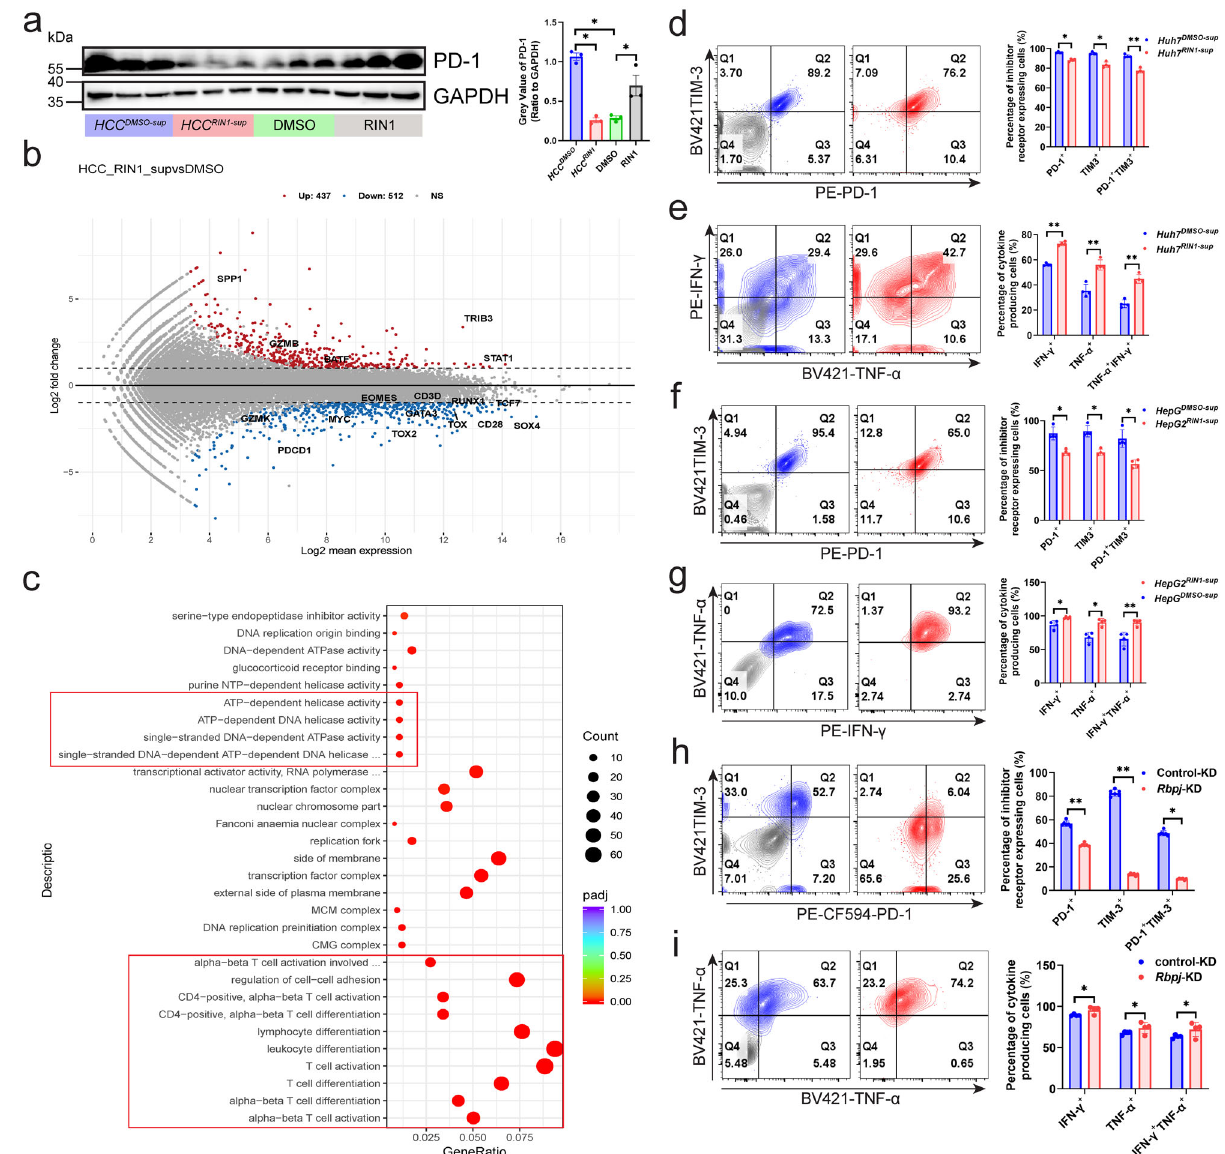
Fig. 4 Regulatory effect of HCC RIN1-sup on the transcriptional pro fi le of CD8 + T cells. a Western blot showing PD-1 expression in mouse HCC in fi ltrating CD8 + T cells ( n = 3). b MA plot of RNA-seq data from Huh7 DMSO-sup versus Huh7 RIN1-sup -treated patient HCC in fi ltrating CD8 + T cells ( n = 3). Genes with elevated expression in the Huh7 RIN1-sup -treated CD8 + T cells ( P adj < 0.05 and log2(fold change) > 1) were marked in red, genes with reduced expression ( P adj < 0.05 and log2(fold change) < − 1) were highlighted in blue. Selected genes were labeled. c GO enrichment analysis of RNA-seq data from Huh7 DMSO-sup versus Huh7 RIN1-sup -treated CD8 + T cells ( n = 3). d – g Expression of inhibitory receptors ( d , f ) and cytokines ( e , g ) on CD8 + T cells from Huh7 RIN1-sup ( d , e ) and HepG2 RIN1-sup ( f , g ) ( n = 4). Gray indicated isotype control. h , i Expression of inhibitory receptors ( h ) and cytokines ( i ) on CD8 + T cells from the tumors of control-KD and Rbpj -KD ( n = 7). Gray indicated isotype control. Mea n ± SD. Statistical signi fi cance determined by paired two- tailed t -test ( a , b , d – i ). * P < 0.05; ** P < and increases hepatic lipid content 17 . To investigate how L-kynurenine by RBPJ (Supplementary Fig. 6c). The protein HCC RIN1-sup regulated CD8 + T cells, we employed untargeted metabolomics to analyze metabolomic alternations in Huh7 cells treated by RIN1. Findings: (1) RIN1 inhibited tryptophan meta- bolism (decreased secretion of 5-hydroxyindoleacetate, serotonin, N-formylkynurenine, and L-kynurenine) (Fig. 5a, b). Cytological experiments con fi rmed that RIN1 did decrease L-kynurenine secreted by Huh7 and HepG2 cells (Fig. 5c, d), which was caused by the reduction of TPH-1 and IDO1 expression from the translational level (Fig. 5e, f) rather than the transcriptional level (Supplementary Fig. 6a, b). IDO1-IN-18 (IDO1 inhibitor) and Rodatristat (TPH1 inhibitor) did reduce the promotion of